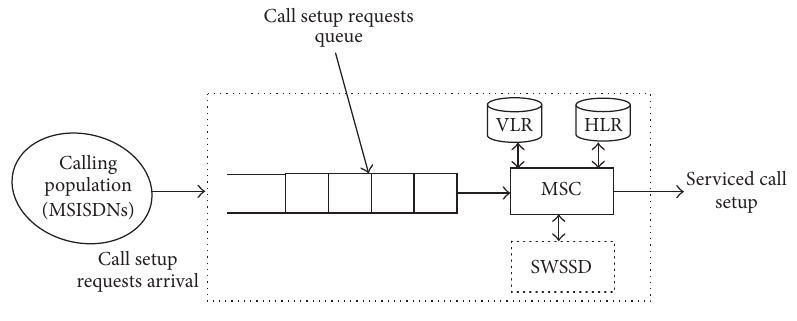
Figure 2: Integrated